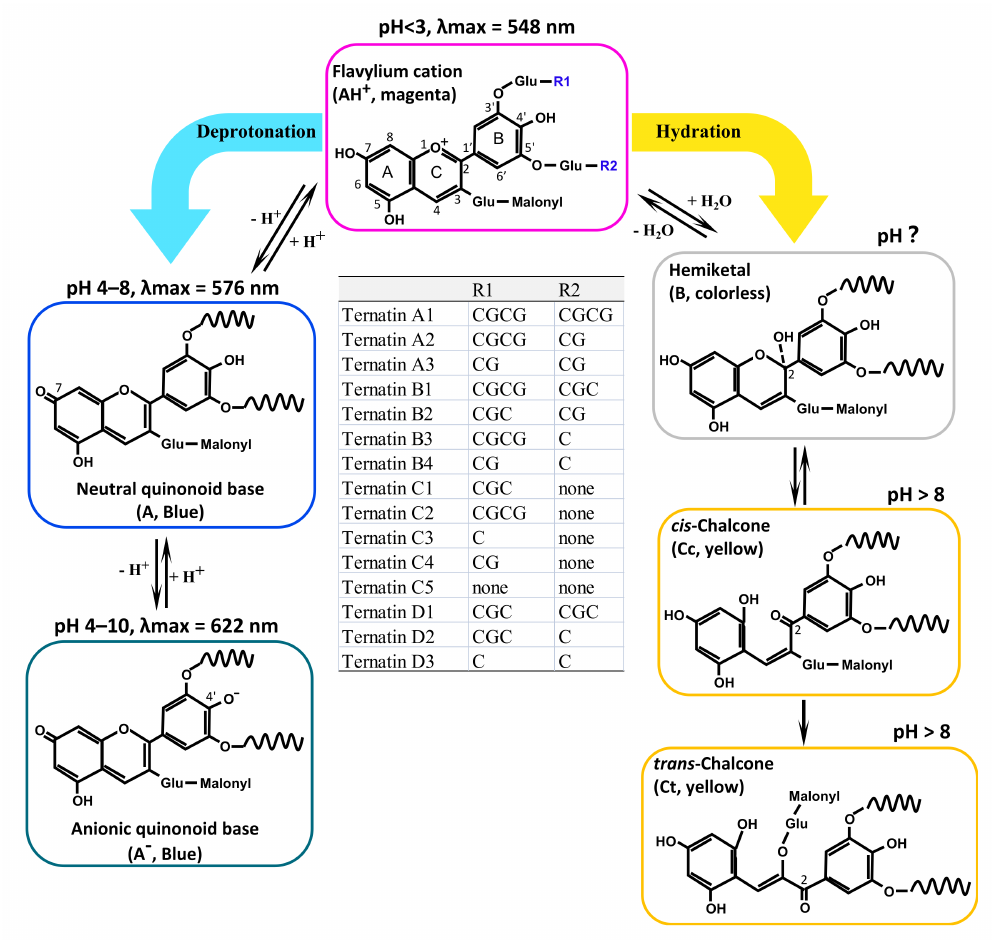
Figure 3. Speculated structural transformation of ternatins with pH variations. In the structure diagrams, D-glucose is simplified as Glu. The inset table shows the side chain variations of the 15 ternatins (A1–A3, B1–B4, C1–C5, and D1–D3) according to Terahara et al. [16–18], in which G is D-glucose and C is p -coumaric acid. The 3 (cid:48) and 5 (cid:48) side chains are simplified as wavy lines in anthocyanin forms other than AH + . The blue and yellow arrows show the two transformation directions for AH + , i.e., deprotonation and hydration, respectively. Speculated pH range for each anthocyanin forms were shown. However, as CTAEs never displayed colorless, a question mark was used for the unclear pH range for the colorless hemiketal